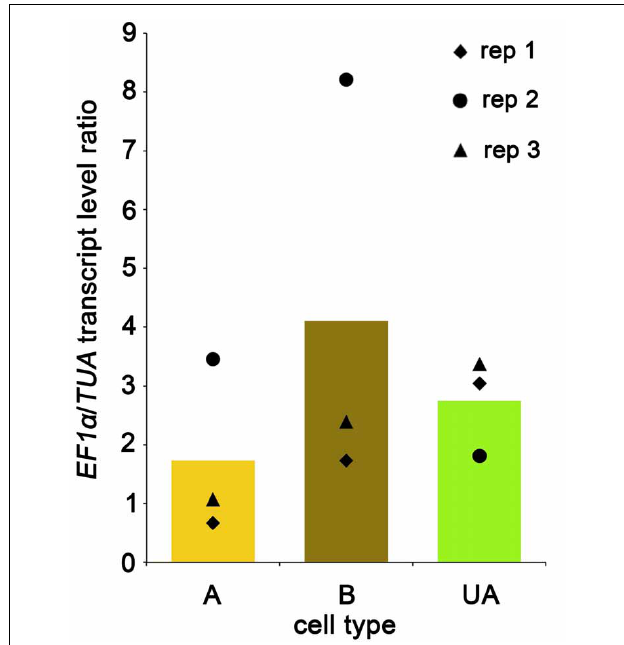
FIGURE 5 | Ratio of EF1 α and TUA transcript levels in amplified cDNA samples from LCM derived A-type, B-type and UA-type cells. EF1 α / TUA ratio is shown in the three biological replicates. Average expression by cell type is depicted as a